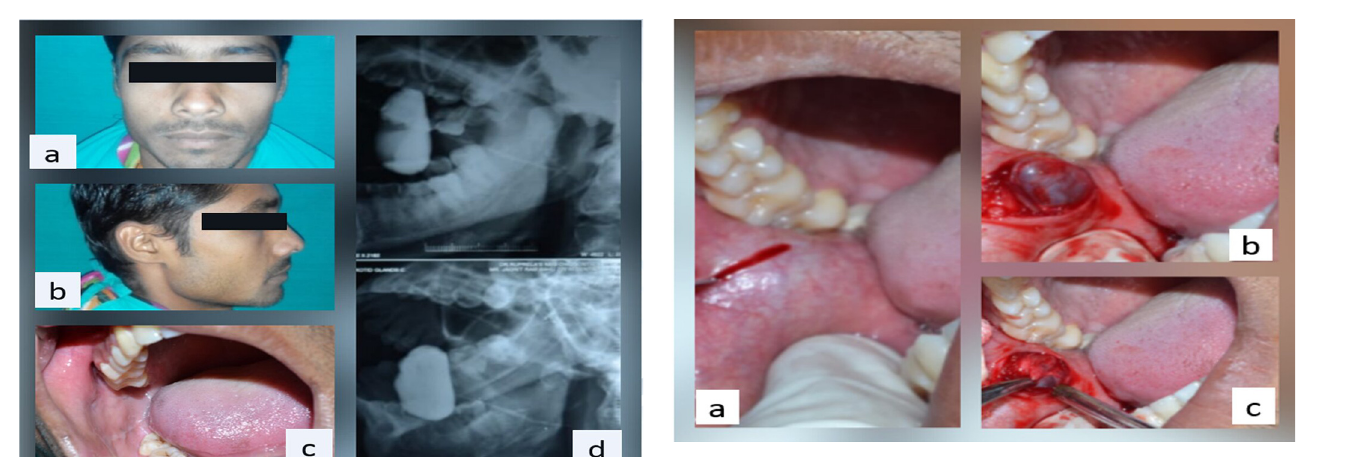
Fig. 3. The intraoperative pictures of (a) incision placement, (b) cystic bag appearance of the lesion, (c) curettage after